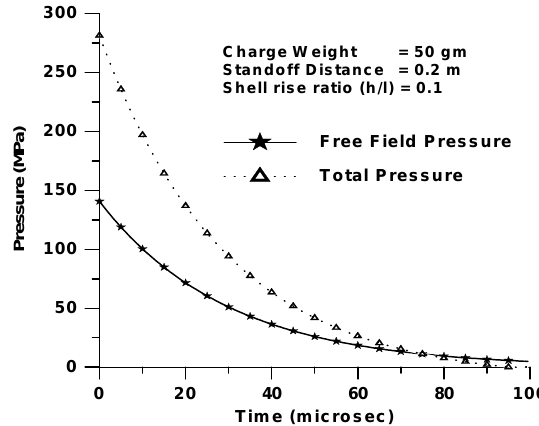
Fig. 4. Typical pressure time history at the center of the panel.